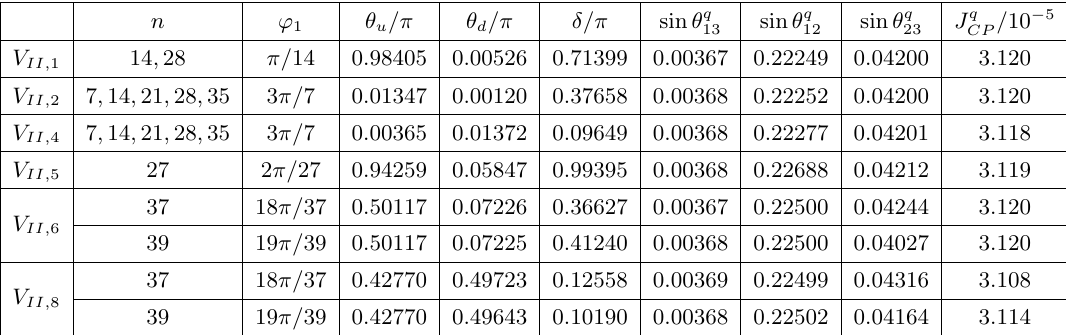
Table 7 . Numerical results of the quark mixing parameters for the permutations of the mixing matrix V II in eq. (5.5), where the residual symmetry is Z g u